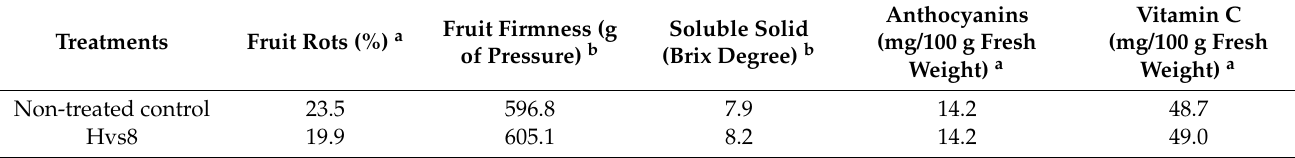
Treatments Non-treated